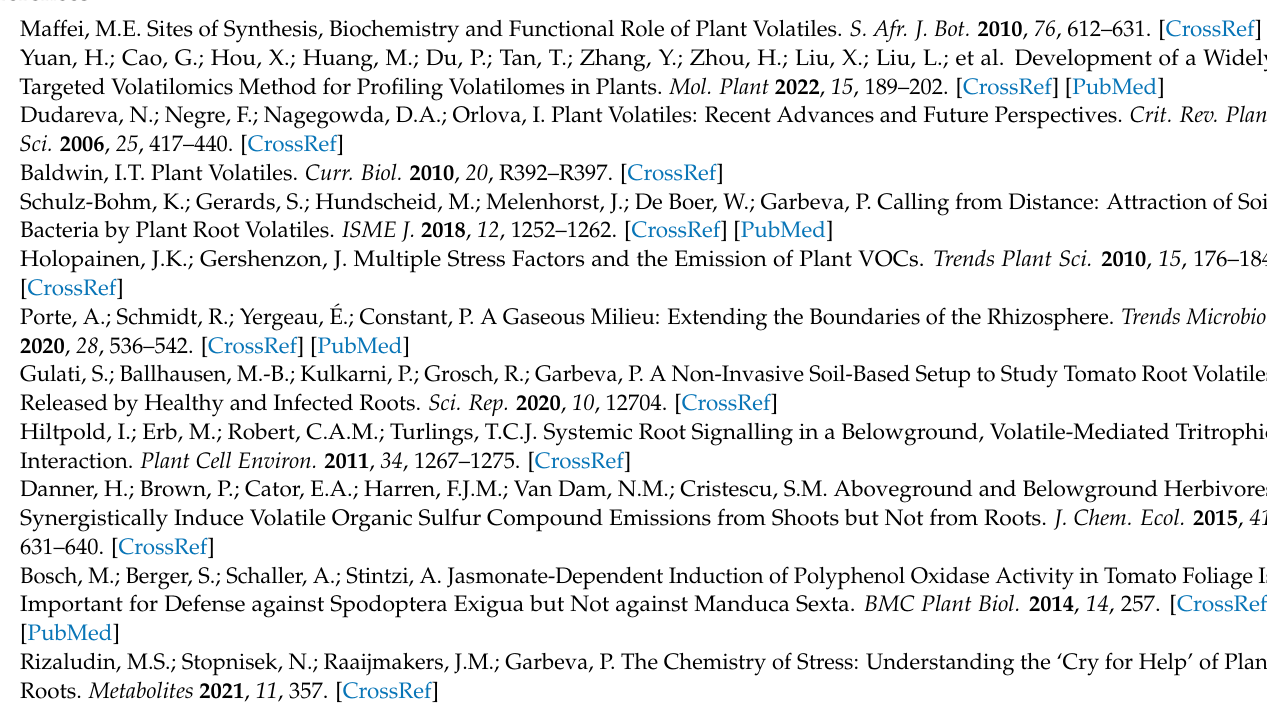
Table S1: Spodoptera exigua artificial diet; Table S2: Parameters used for data processing using MZmine 2.53 (ADAP); Figure S2: Comparison of root biomass (dry weight) between treatments; Figure S3: Correlation plot between root VOC ( α -pinene) with root